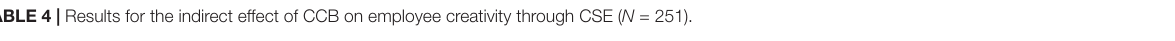
TABLE 4 | Results for the indirect effect of CCB on employee creativity through CSE ( N = 251). Sobel for the indirect effect Bootstrap for the indirect